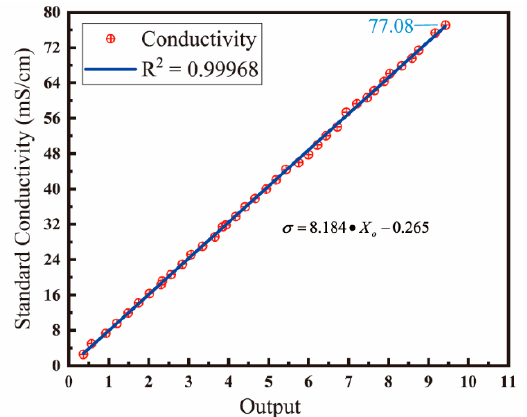
Figure 8. Fitted curve calibrated in the laboratory, calibrated by standard conductivity solutions with different concentrations.